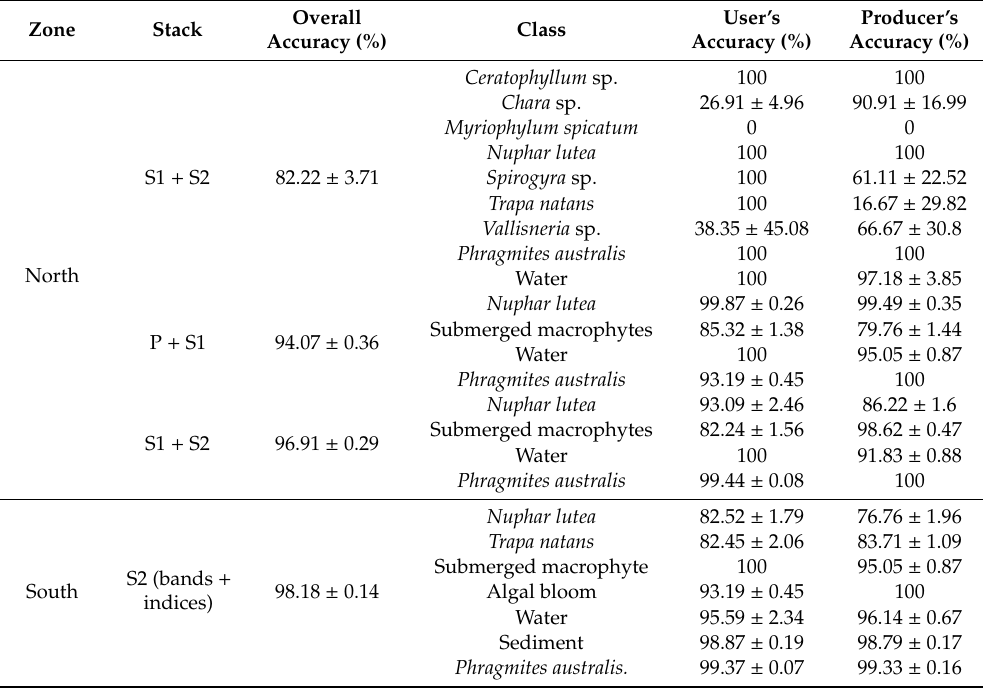
Table 4. Some examples of the best results by the classification of the user’s accuracy (%), producer’s accuracy (%) and standard errors of the macrophytes.